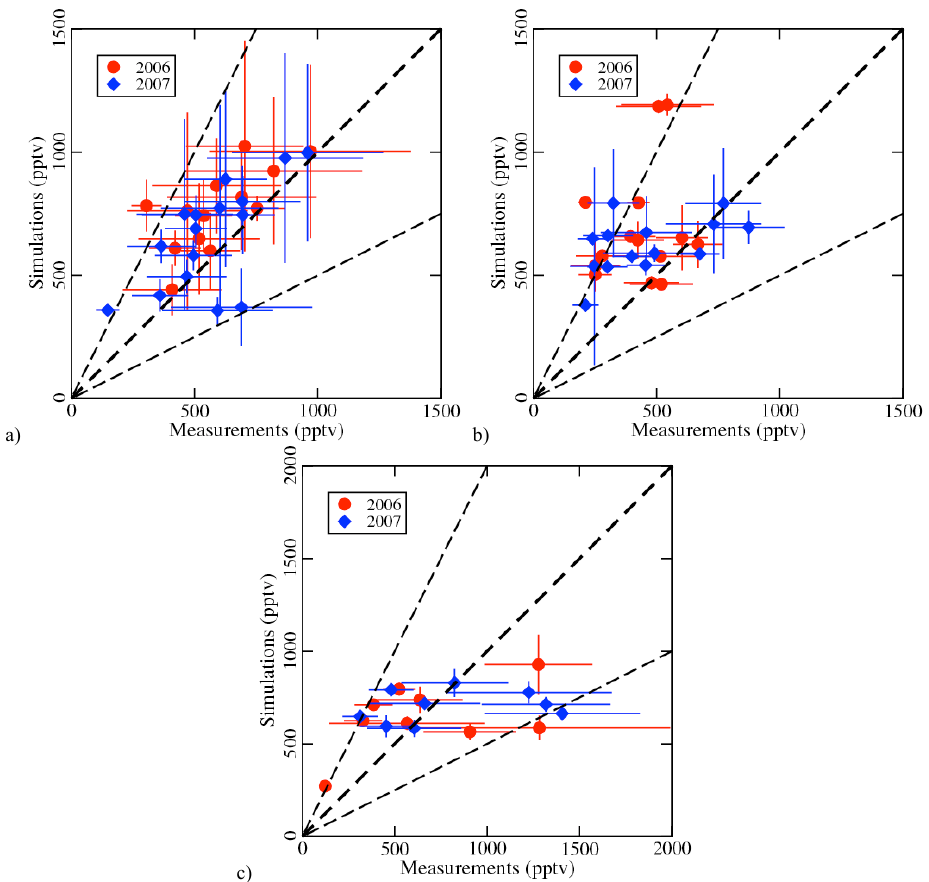
Figure 4. As Figure 3 except no distinction is made with air mass fingerprint but with geography and flight averages are plotted instead of seasonal averages: (a) Central-South China, (b) China Sea, and (c) Europe-Mediterranean region.